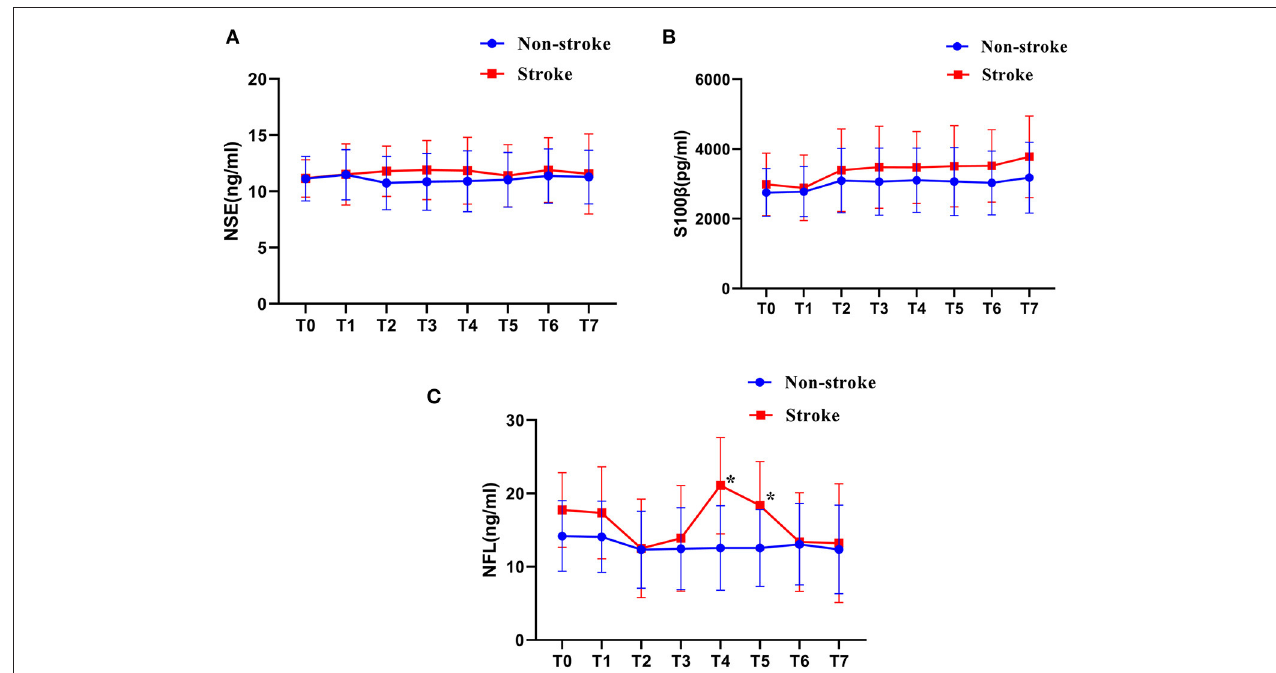
FIGURE 1 | (A–C) Biomarker comparison across groups and time points * P < 0.001.